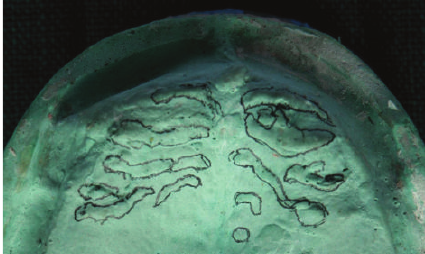
Figure 2: Photograph showing highlighted palatal rugae on maxil- lary edentulous cast.